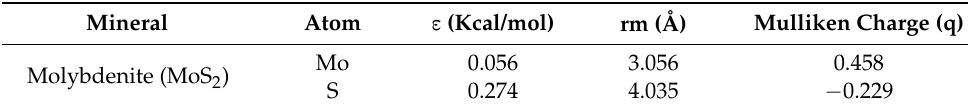
Table 1. Force field parameters for molybdenite (MoS 2 ).